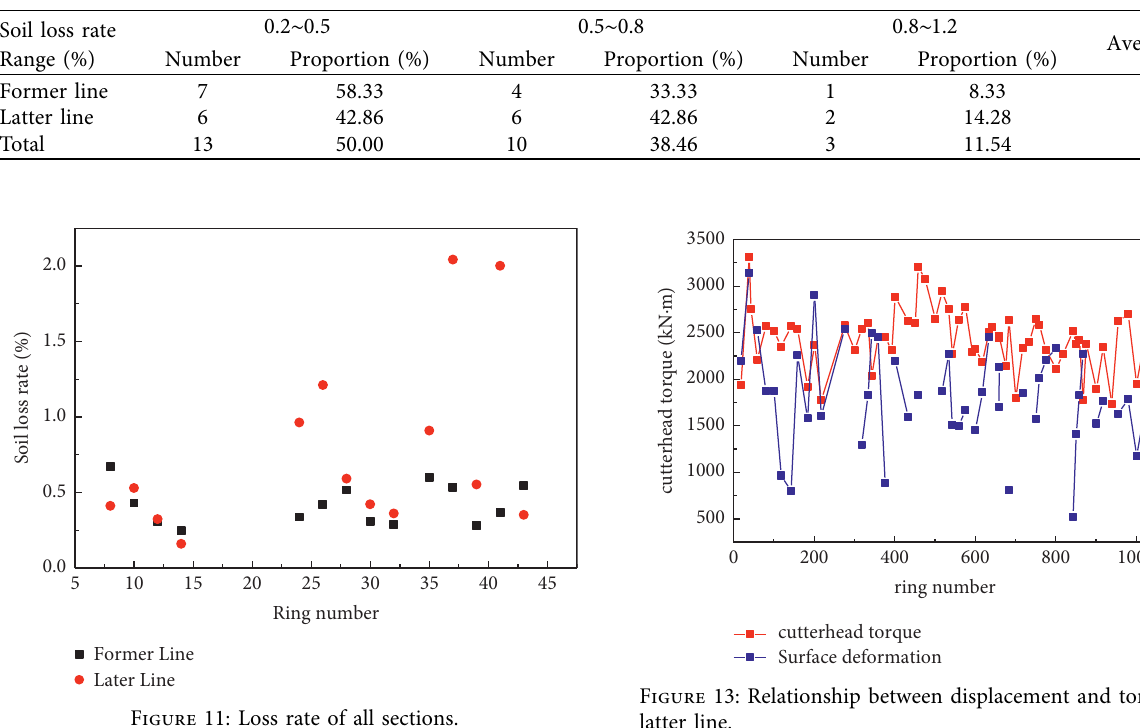
Table 3: Distribution of loss rate in soft soil region in Hangzhou Metro Line 2.